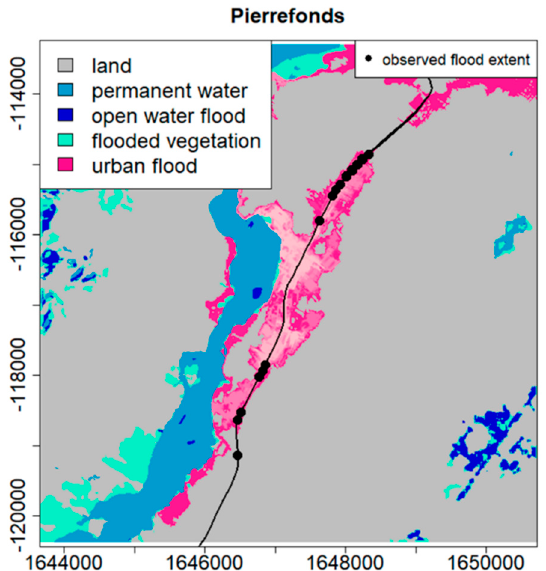
Figure 10. A range of simulated urban flood extents represented by different shades of pink, flood-filled using a Lidar DEM seeded from single flood perimeter observations represented by black dots along Pierrefonds Boulevard.